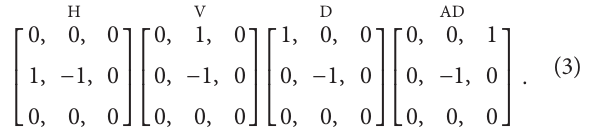
3.1. Traces of Interpolation. Compared with unaltered image, due to interpolation, resampled and forged resampled